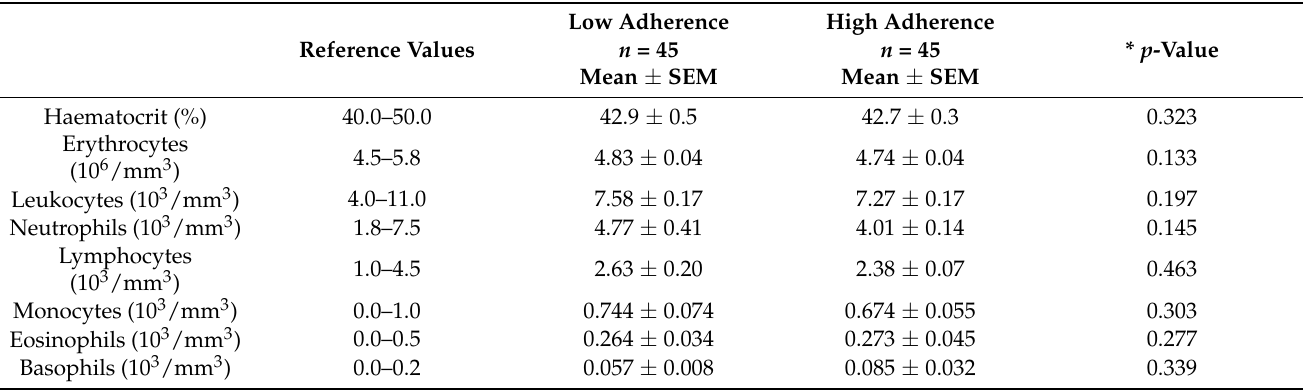
Table 3. Haematological parameters of participants according to median values of adherence to the Mediterranean Diet